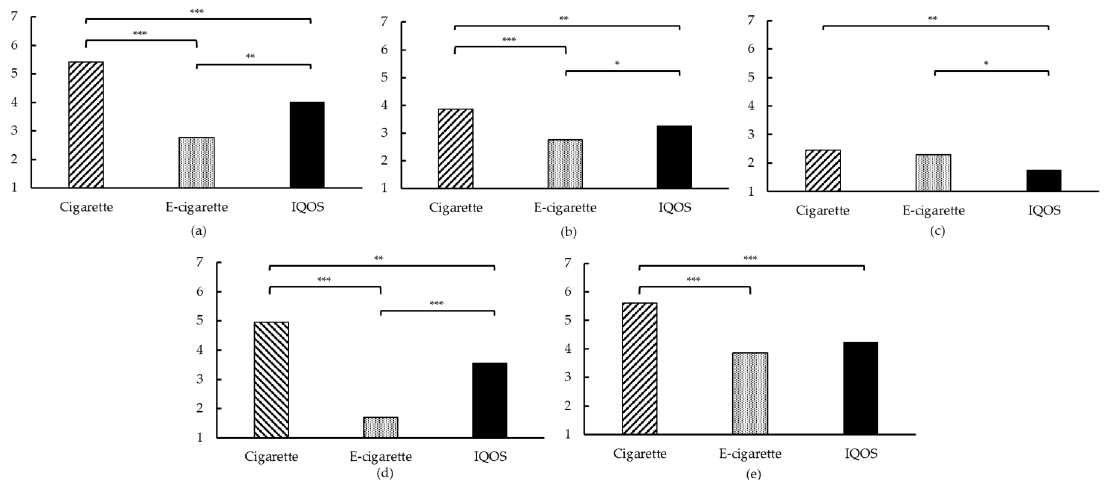
Figure 4. Modified Cigarette Evaluation Questionnaire (mCEQ) subscales. ( a ) “ Satisfaction ”; ( b ) “ Psychological reward “; ( c ) “ Aversion “; ( d ) “ Enjoyment of respiratory tract sensations “; ( e ) “ Craving reduction ”; for (a–e): * p < 0.05, ** p < 0.01, *** p < 0.001.